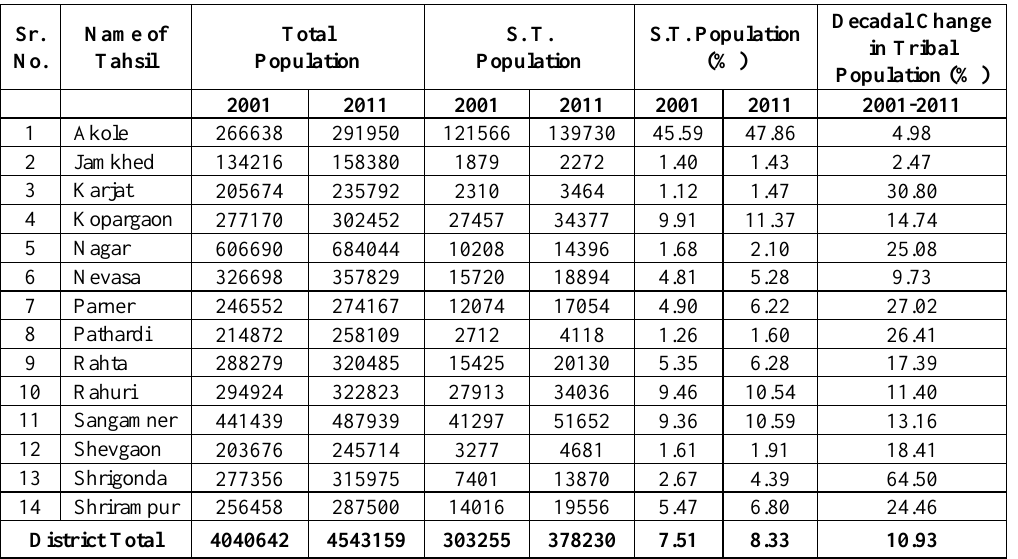
Table 1. Distribution of Scheduled Tribe in Ahmednagar